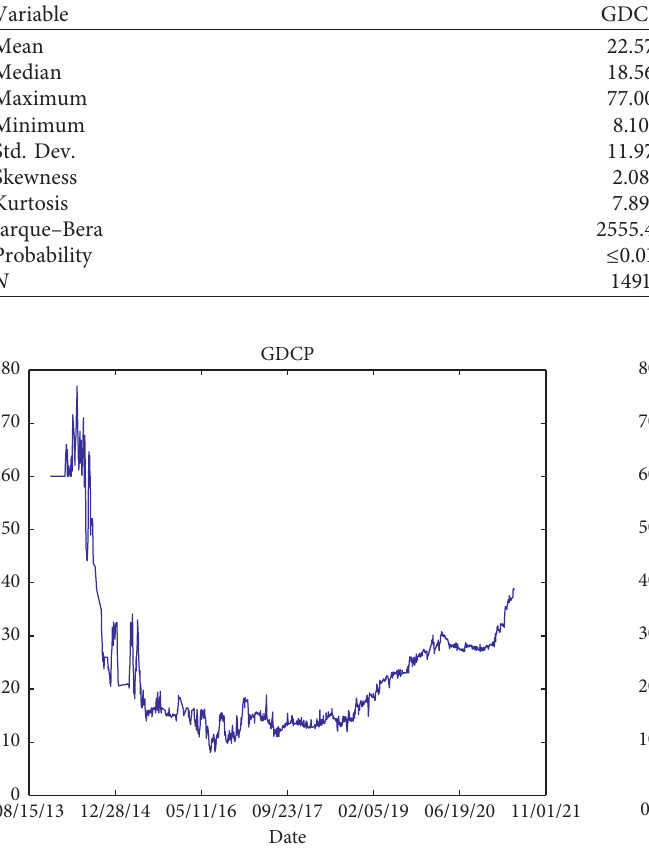
Figure 2: Evolution pattern of US economic policy uncertainty index